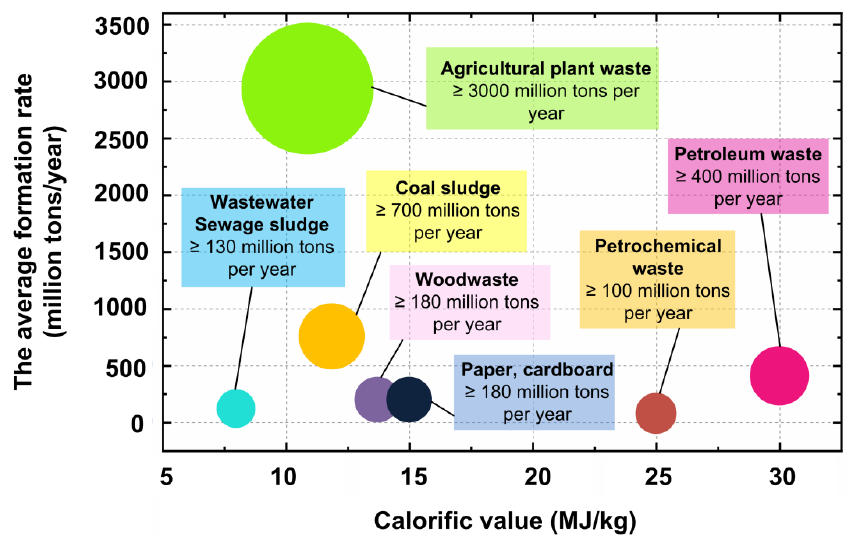
Figure 1. Calorific value of wastes and their average global generation rate (according to [13,34–37]). Table 1 provides a list of typical components used to create fuel slurries and blends. Table 1. Properties of the components used for the preparation of fuel